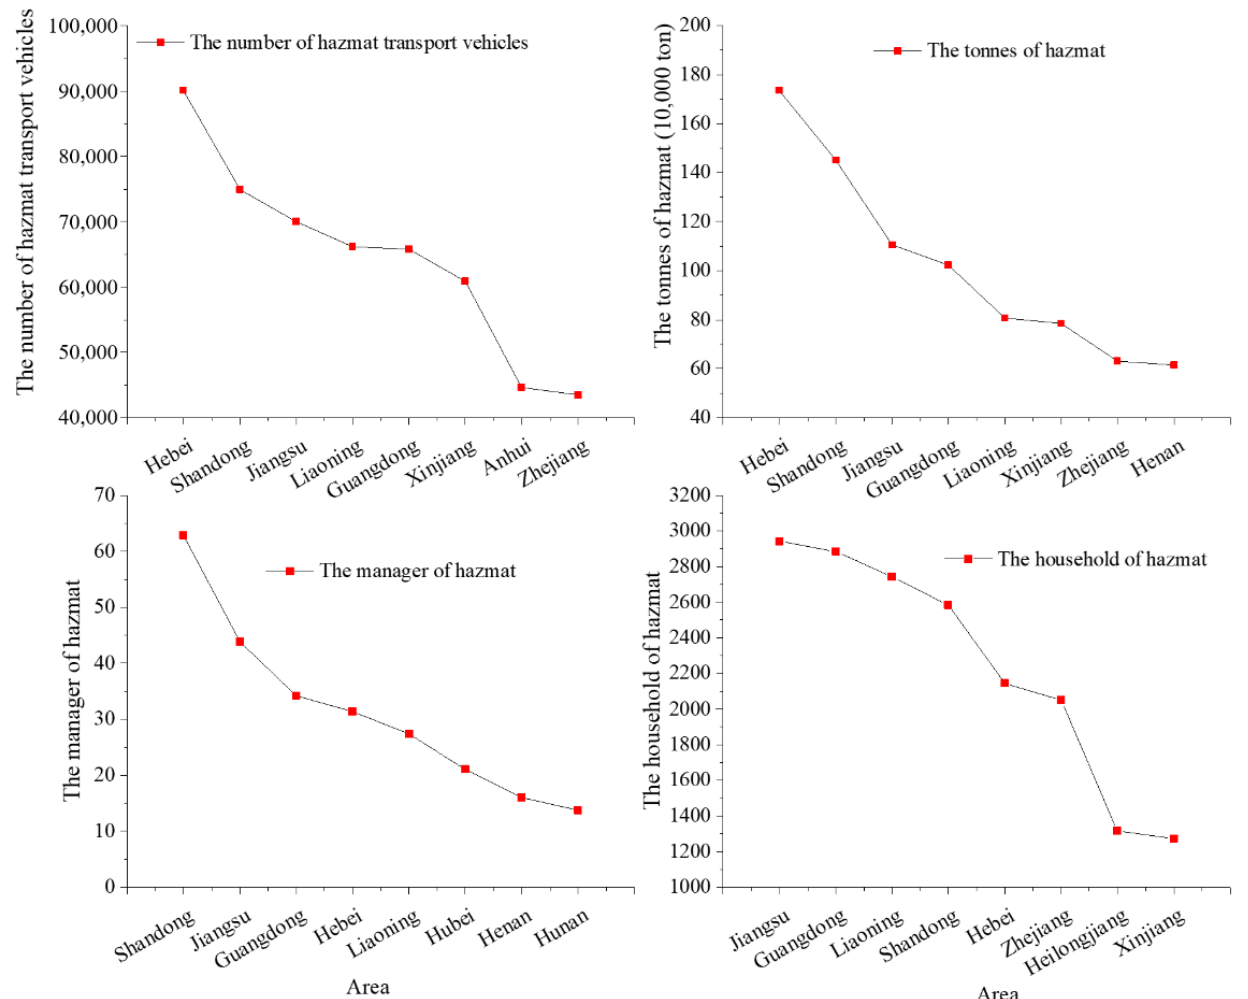
Figure 6. Distribution of hazmat transport vehicles and tons and the number of hazmat managers and households by the province of